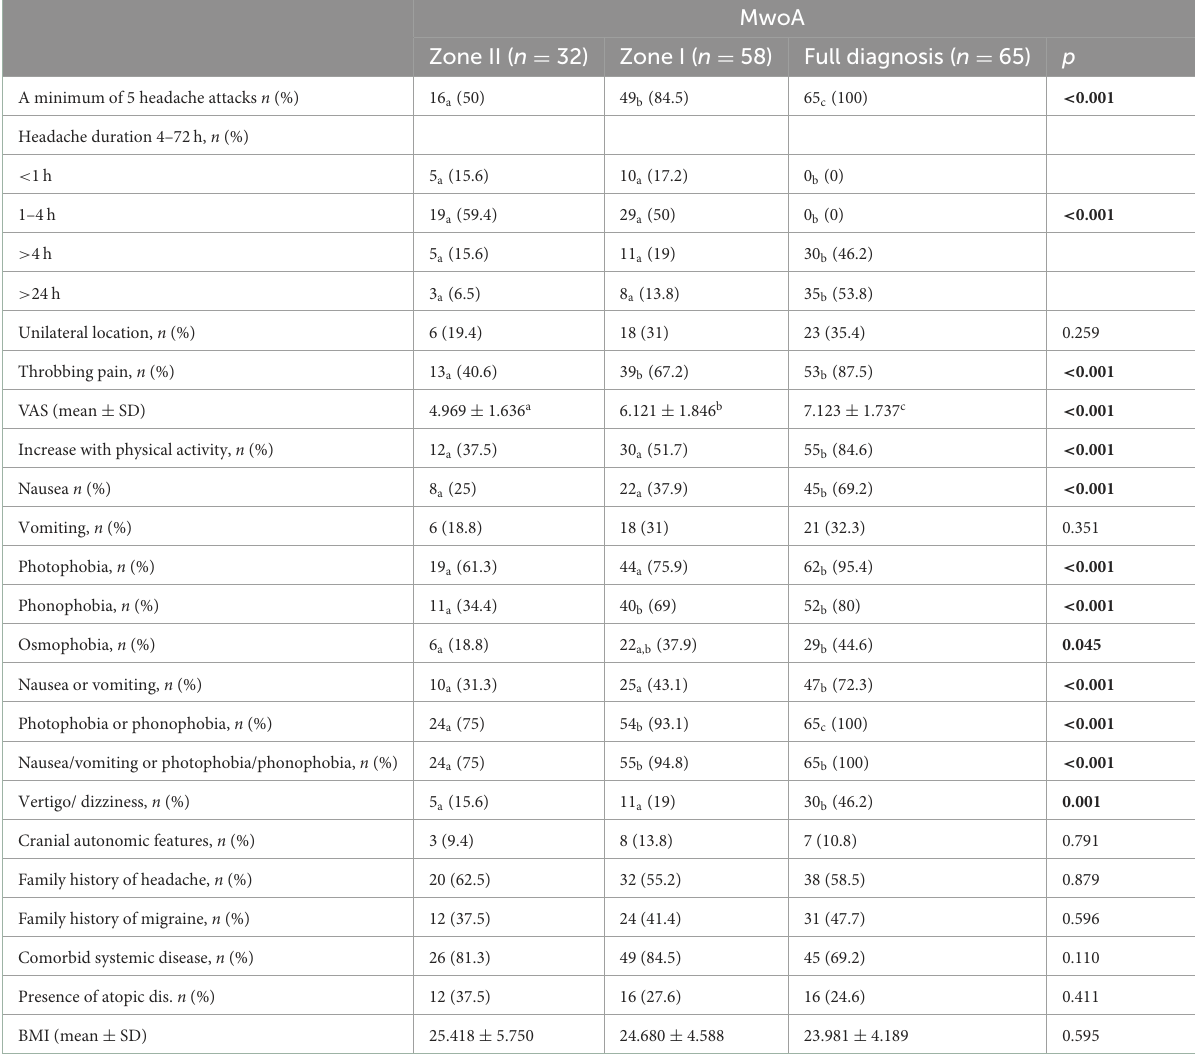
TABLE 1 The distributions of patients with idiopathic/genetic epilepsy (I/GE) with migraine without aura (MwoA) with regard to full diagnosis, zone I, and zone